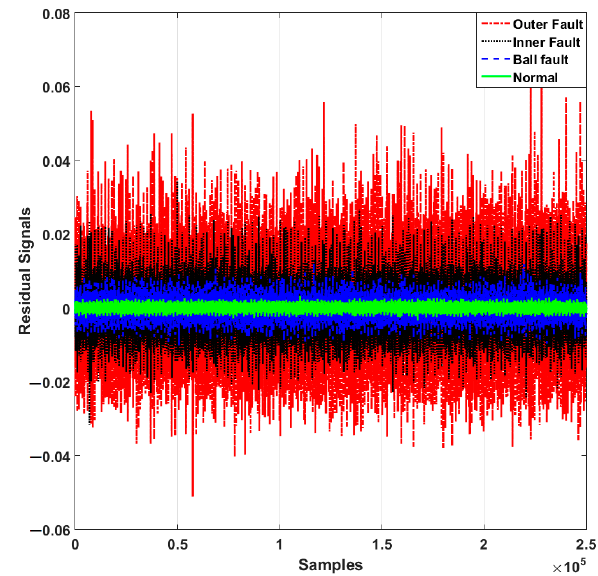
Figure 3. The residual signals for the CWRU dataset using the FOR (fuzzy orthonormal regressive)-adaptive cascade observation procedure.